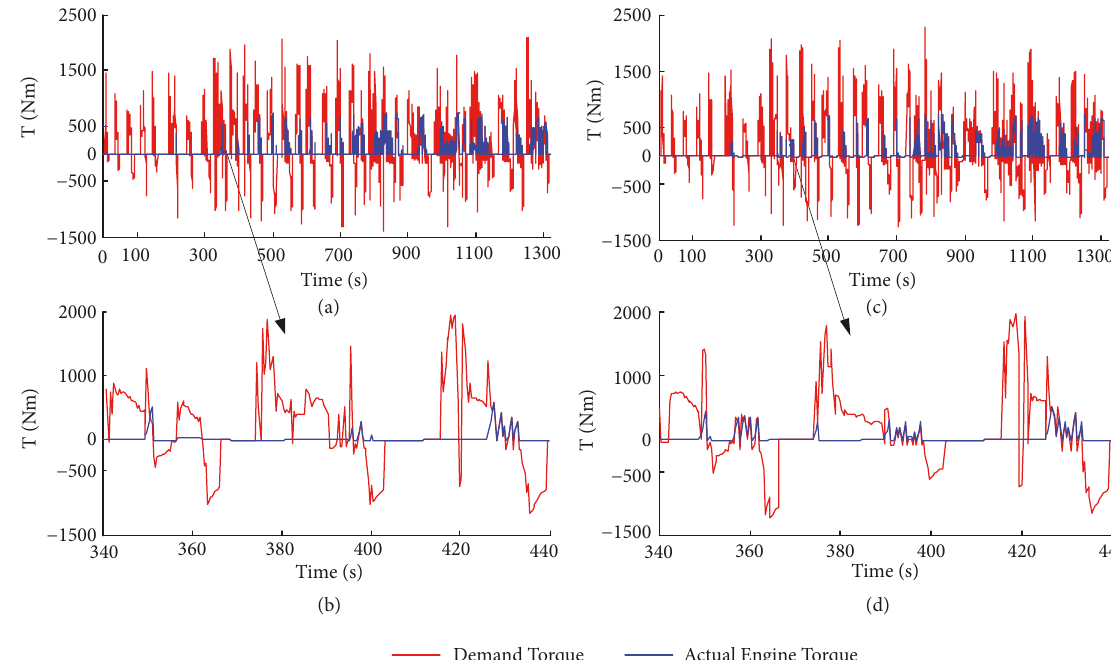
Figure 16: Demand torque and ICE torque of two